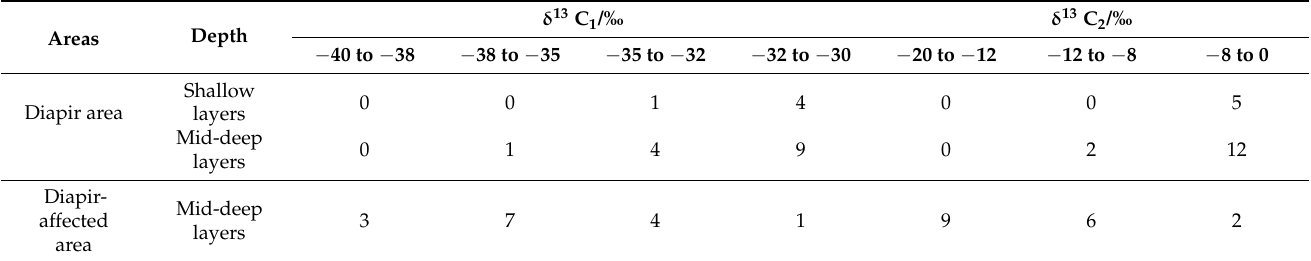
Table 2. Sample statistics of the gas-charging sequence in the DF area, Yinggehai